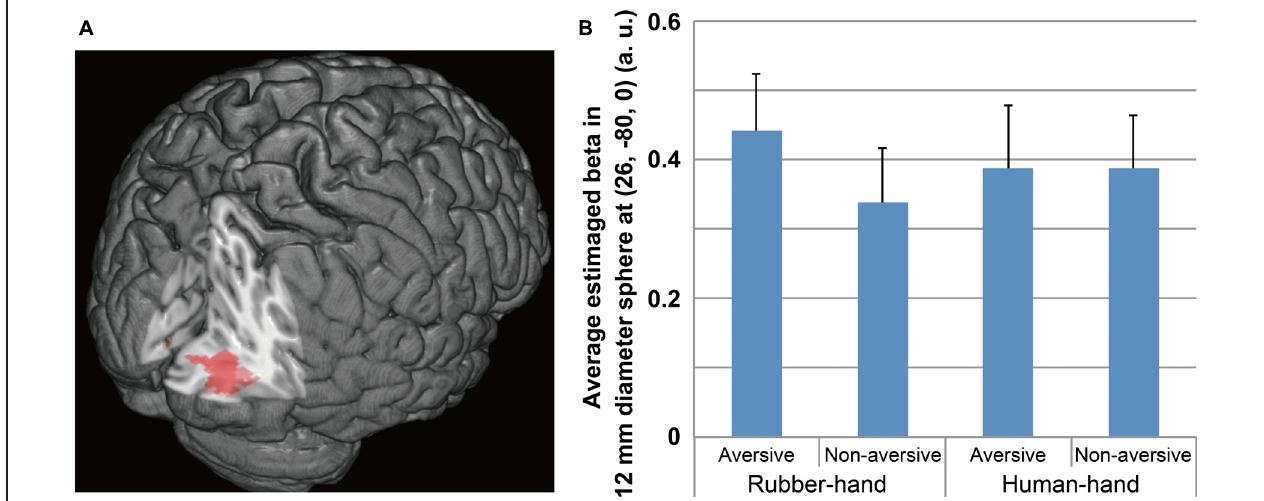
FIGURE 4 | Significant activation for the interaction between hand and aversiveness conditions. (A) Significant cluster is shown. The peak of the significant cluster is located at the section. (B) Average estimated beta of each condition in 12 mm diameter sphere at (26, –80, 0) is shown. The threshold of